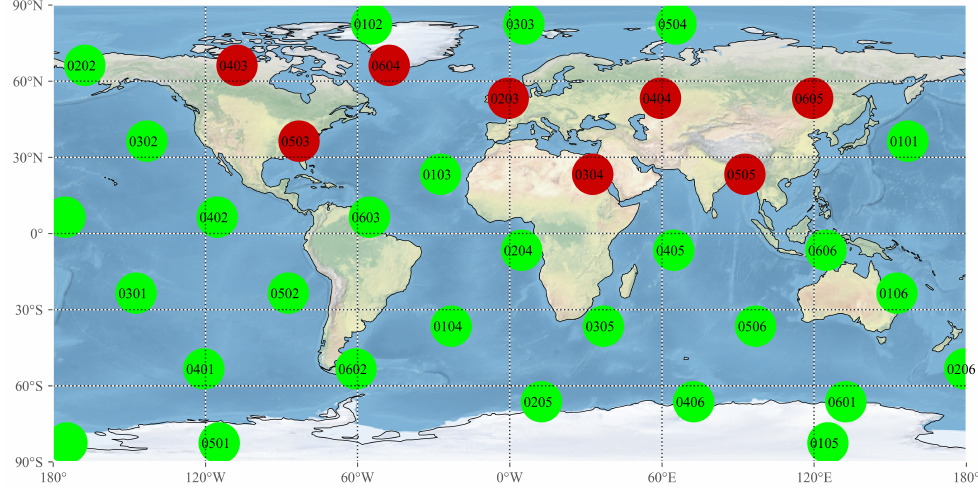
Figure 5. Constellation 1